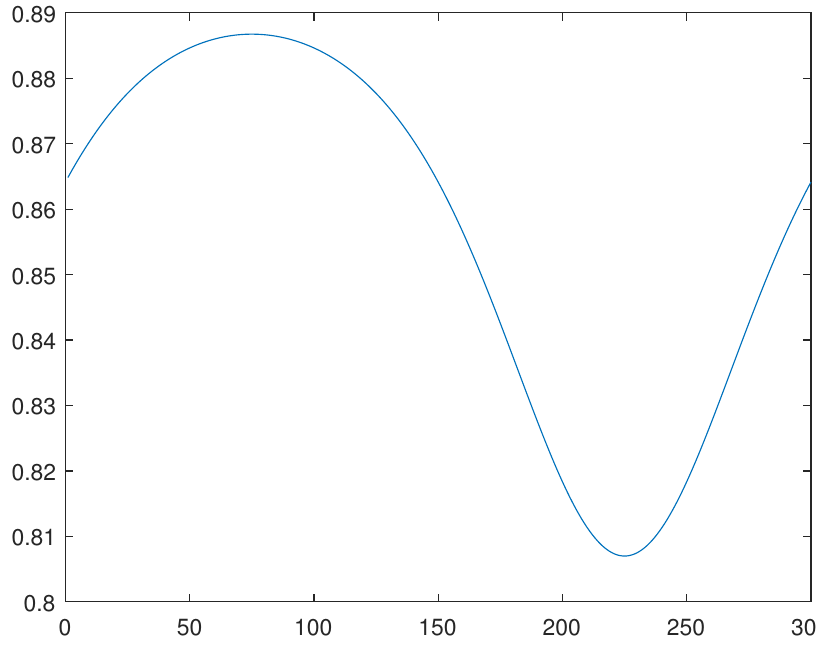
Figure 2. Line 2, solution u 2 ( x ) through Newton’s